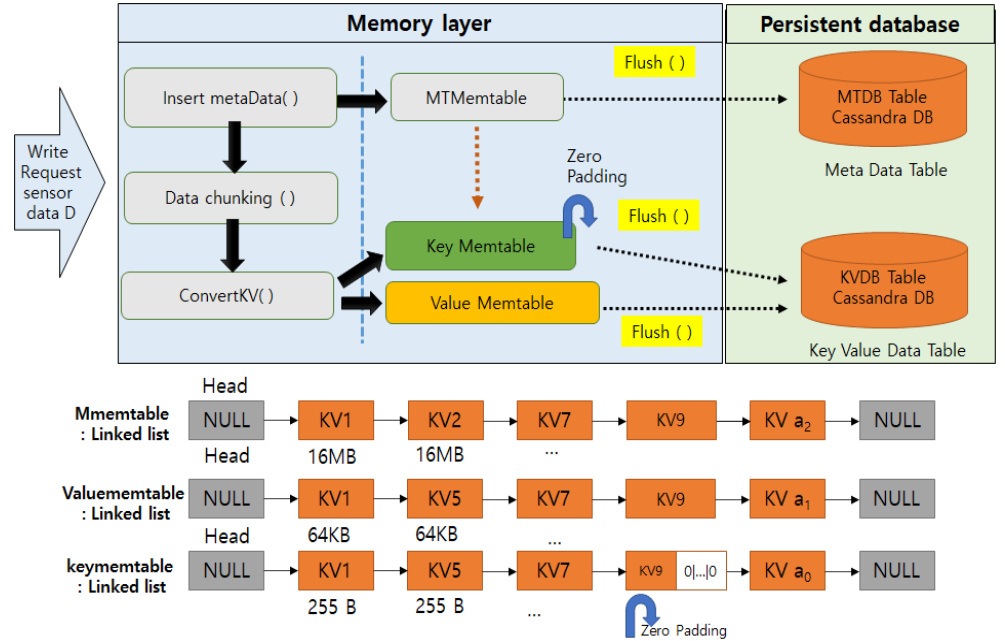
Figure 3. In-memory data scheduling implemented as